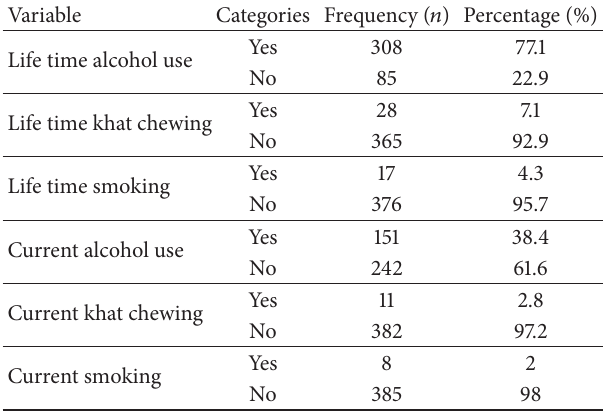
Table 3: Substance use of HIV positive respondents at Debark Hospital Northwest, Ethiopia, 2015 ( 𝑛 = 393 ).